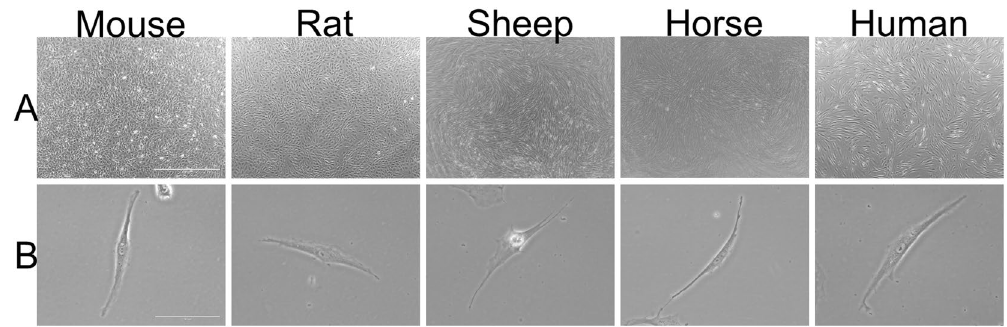
Figure 1. Micrographs of tenocytes derived from the Achilles tendon in the mouse, rat, sheep and human or the superficial digital flexor tendon in the horse. ( A ) shows the tenocytes at a magnification of 40x (scale bar: